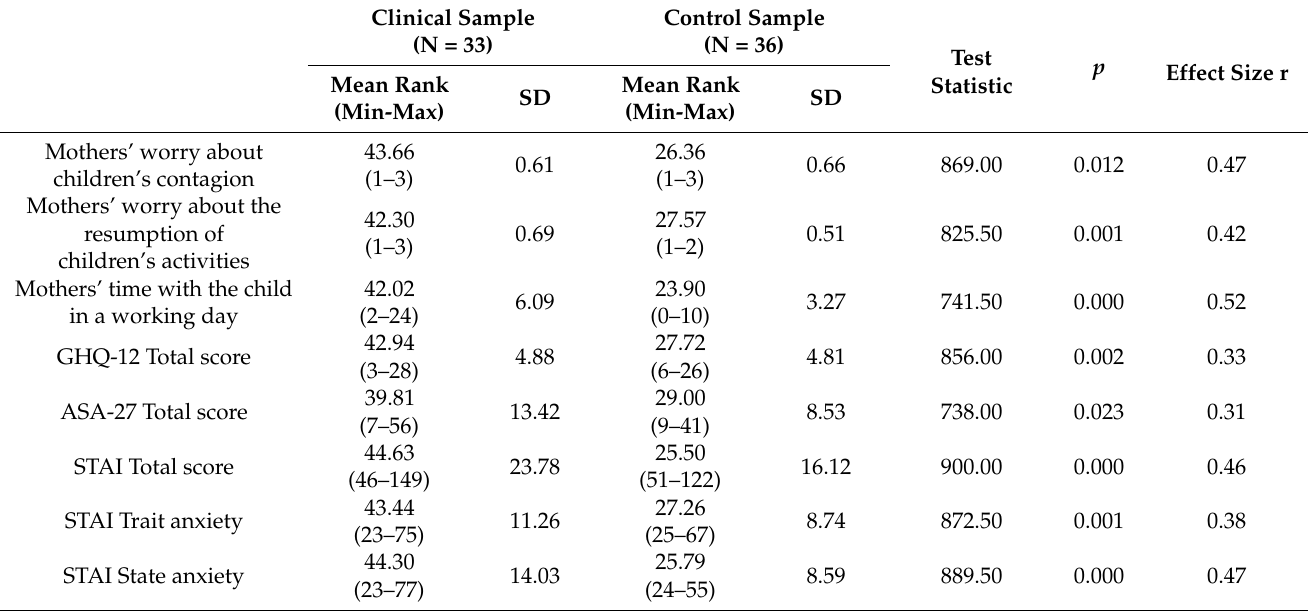
Table 3. Mann–Whitney U tests used to evaluate the differences between mothers of the clinical and control groups in survey variables and standardized questionnaires. Mean rank, minimum (min) and maximum (max), standard deviations, and test statistics are reported. Effect sizes’ r values: 0.00–0.20